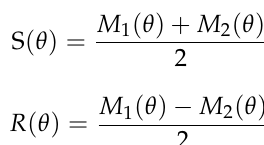
Figure 2. Measurement system and data evaluation of rotary error.